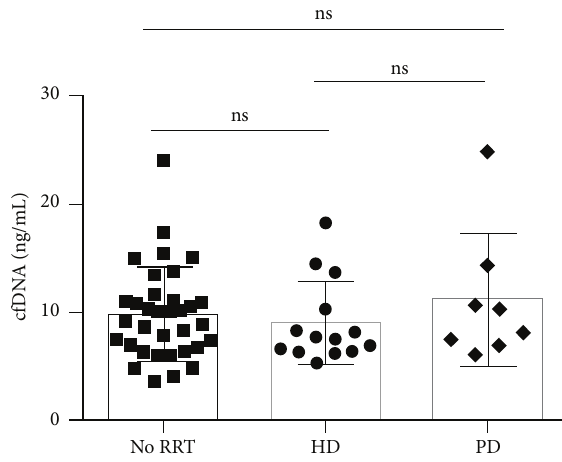
Figure 2: Influence of renal replacement therapy on cfDNA levels. ComparisonofcfDNAlevelsfrompatientsnotonrenalreplacement therapy (RRT) with patients on haemodialysis (HD) or peritoneal dialysis (PD) who participated in the SAFIRE trial. Mean + SD and absolute values are shown ( 𝑃 = 0.6